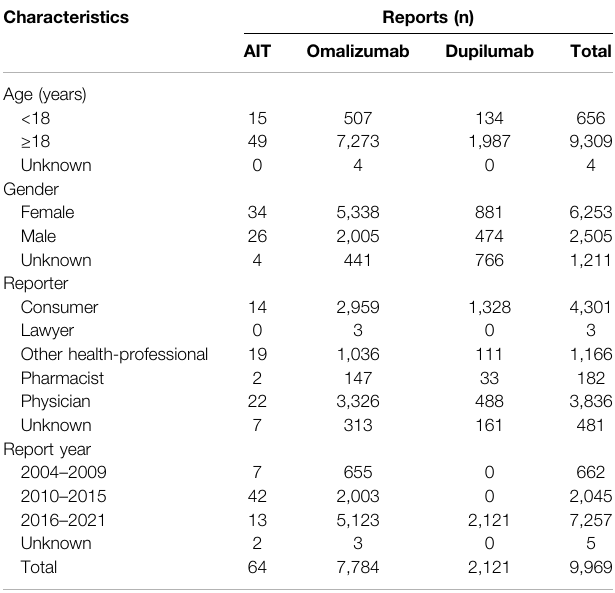
TABLE 2 | Demographic characteristics of cases with AIT, omalizumab, and dupilumab associated anaphylaxis. Characteristics